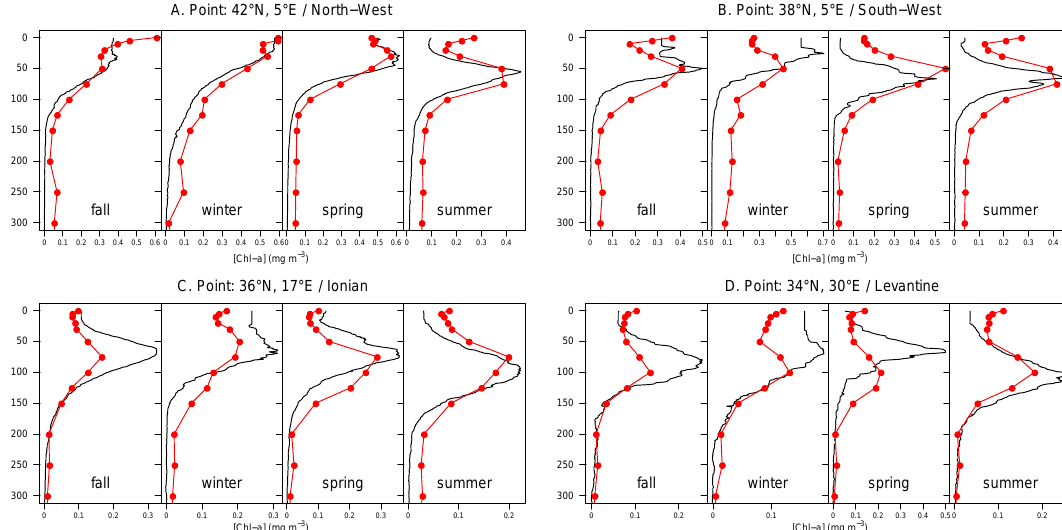
Figure 8. [Chl a ] profiles obtained from the MEDATLAS climatology for the four locations analyzed in Fig. 3 (red lines and red points). MEDATLAS climatology was downloaded from http://modb.oce.ulg.ac.be/backup/medar/medar_med.html. For comparison, corresponding seasonally averaged profiles were computed from the 1998–2014 [Chl a ] fluorescence database (black lines). Seasons are calendar-based